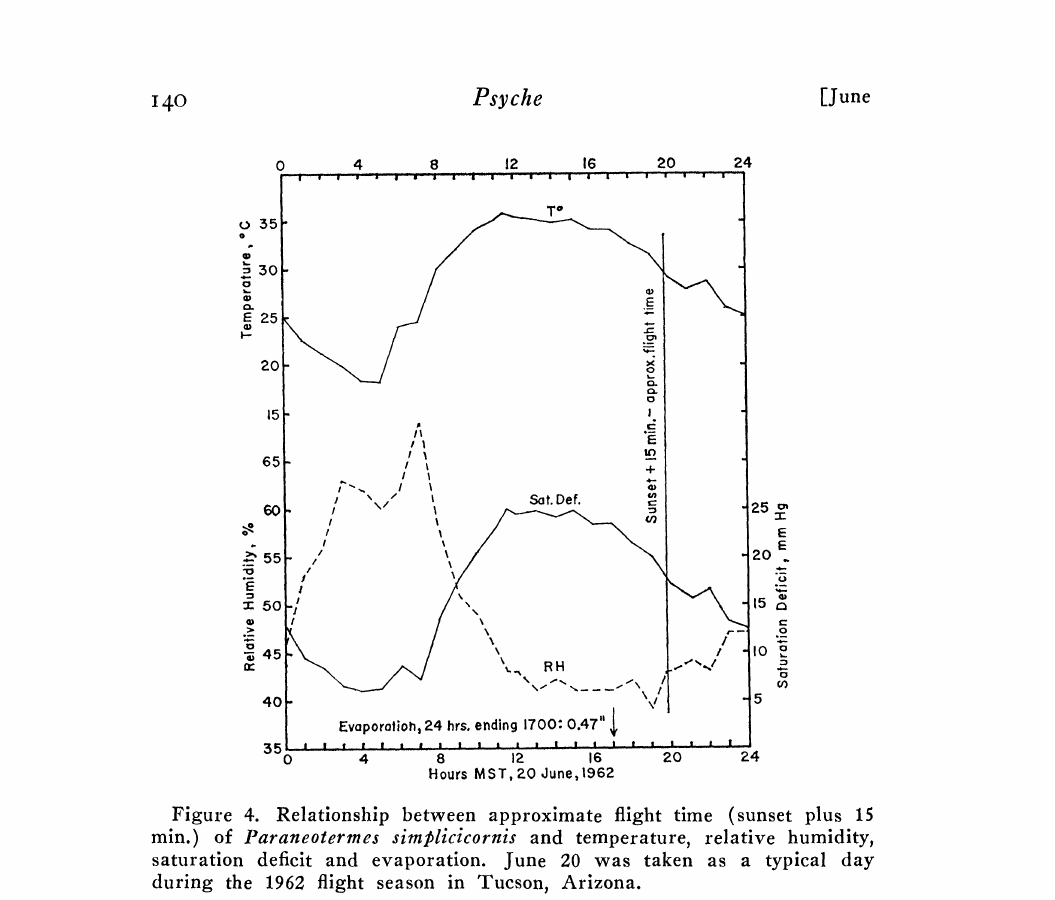
Figure 4. Relationship between approximate flight time (sunset plus 15 min.) of Paraneotermes simllicicornis and temperature, relative